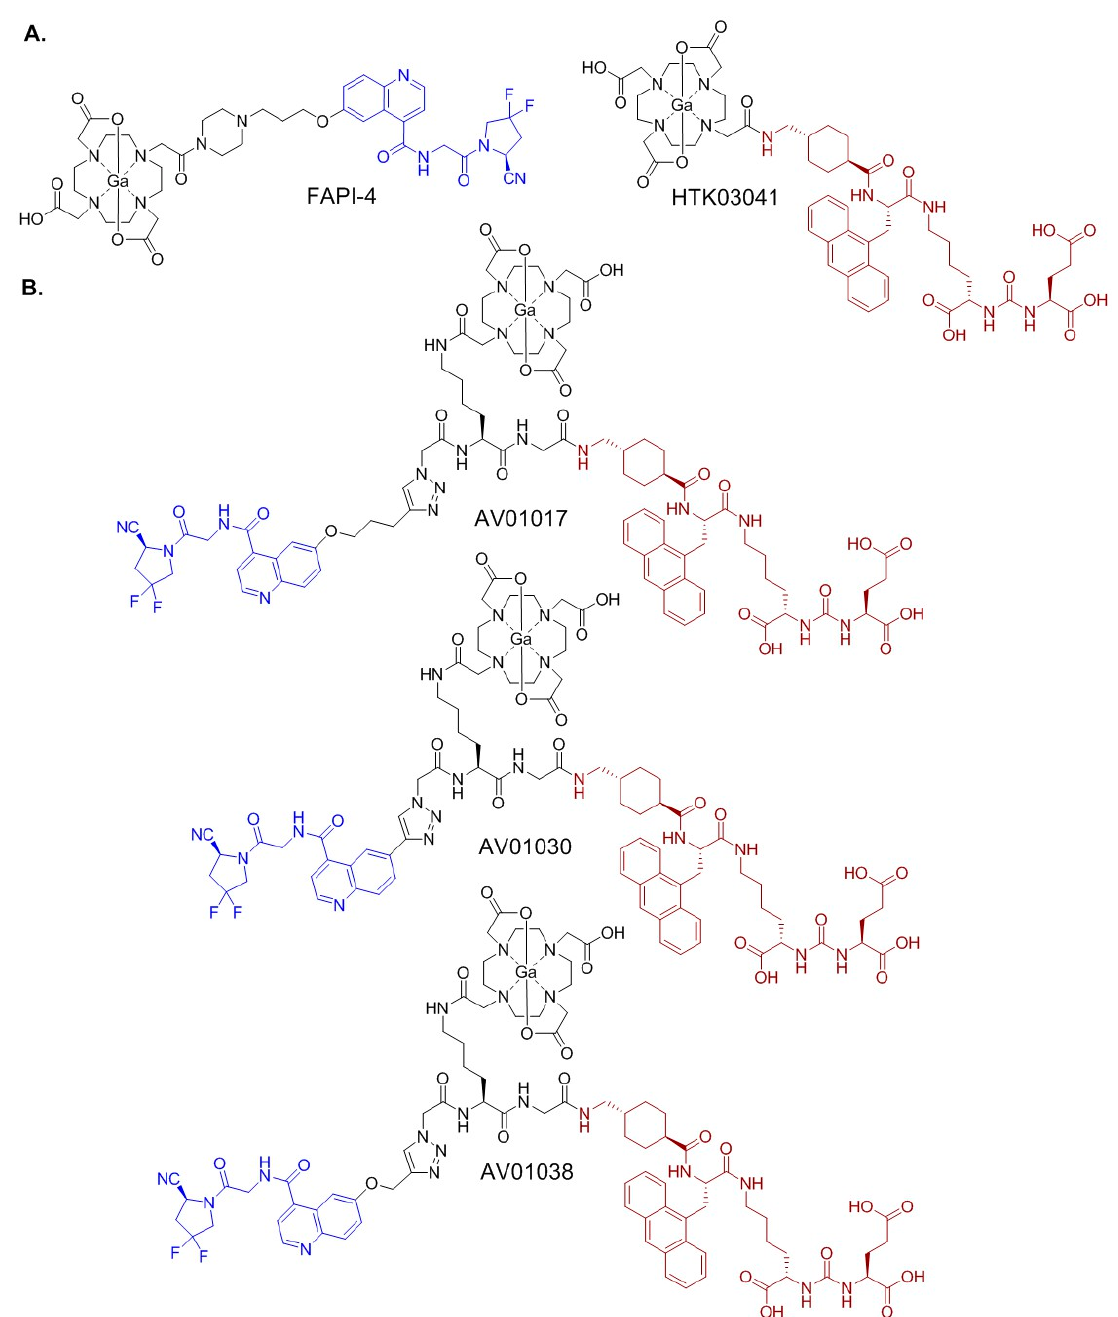
Figure 2. Chemical structures of ( A ) PSMA-targeting [ 68 Ga]Ga-HTK03041 and FAP-targeting [ 68 Ga]Ga-HTK03041; and ( B ) bispecific PSMA/FAP-targeting 68 Ga-labeled AV01017, AV01030, and AV01038. The PSMA- and FAP-targeting pharmacophores are shown in brown and blue, respec- tively.